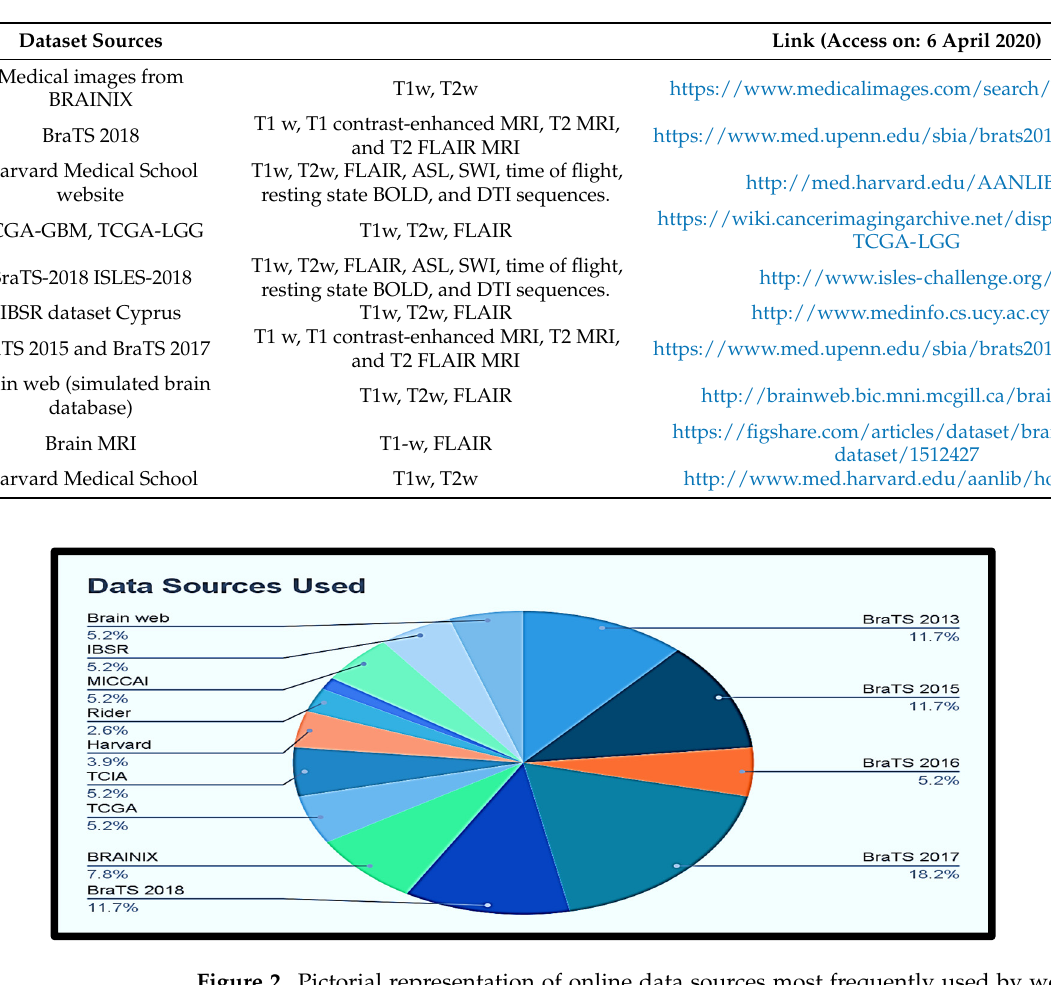
Table 2. Different sources of data and techniques of acquisition.